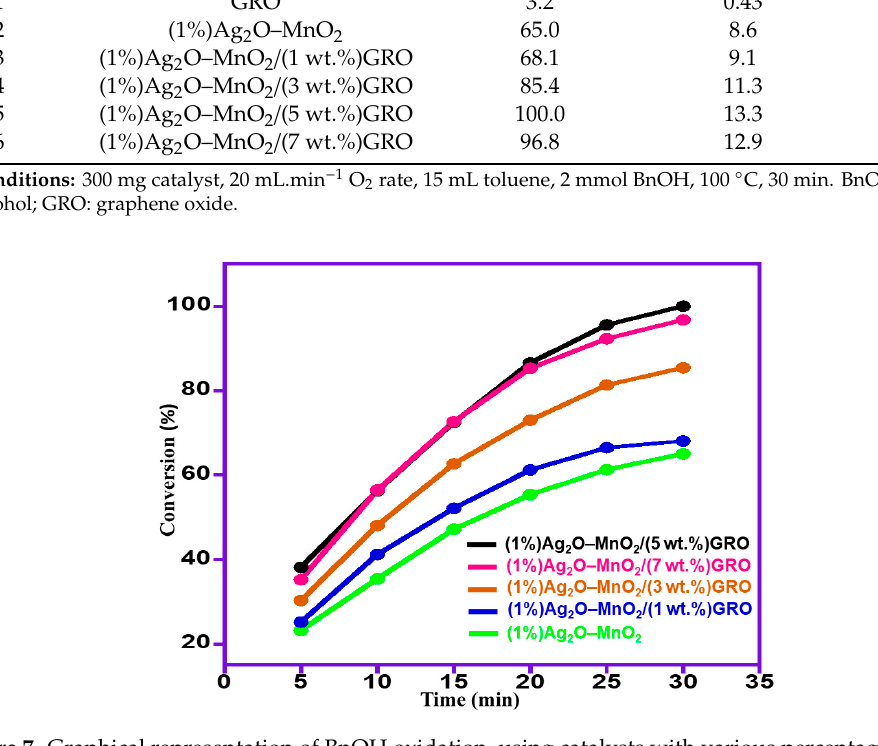
Figure 7. Graphical representation of BnOH oxidation, using catalysts with various percentages of GRO.